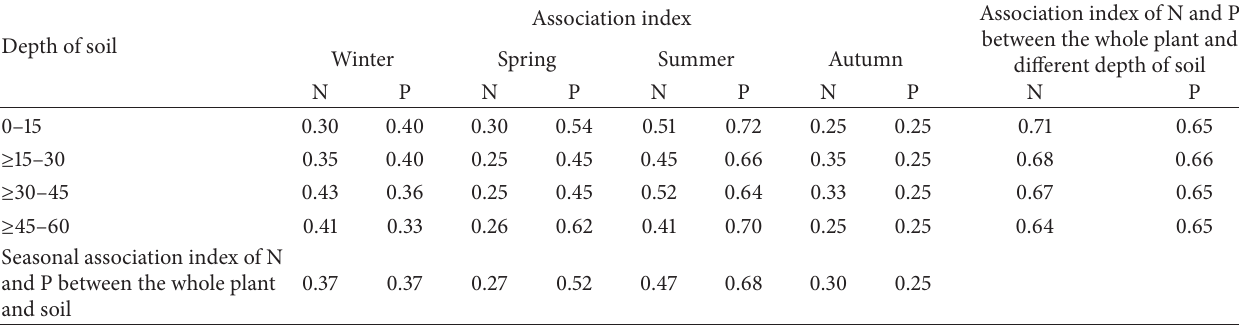
Table 3: Grey Correlation Analysis on contents of N and P between organs of P. australis and different depth of